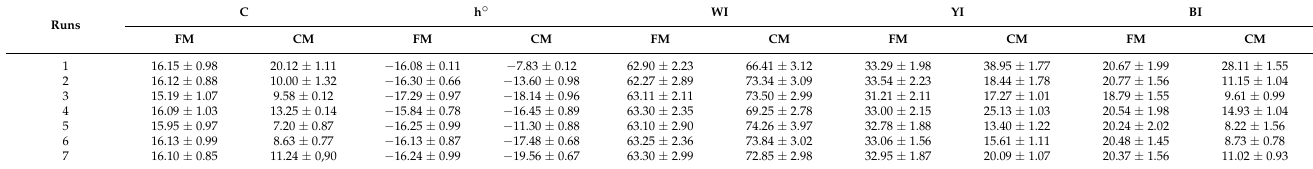
Figure 5. b* value of unconcentrated and concentrated milk. Different letters refer to significant differences between means. Table 1. Chroma, hue angle, whiteness index, yellowing index, and browning index of unconcentrated and concentrated